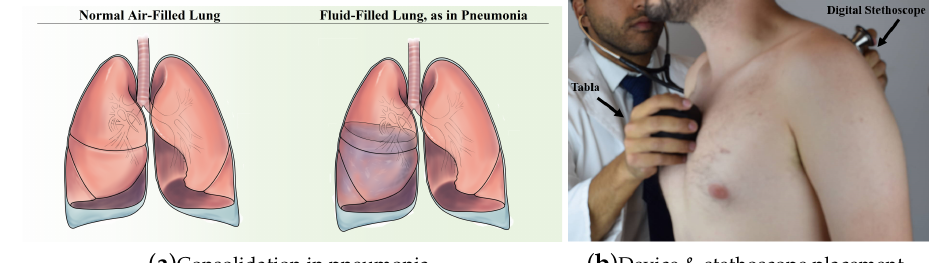
Figure 1. ( a ) a lung with consolidation characteristic of pneumonia and a healthy lung. Pneumonia leads to the accumulation of protein-rich fluid (exudate) in the lungs. The presence of exudate can be detected using different techniques, e.g., chest X-rays and acoustic analysis; ( b ) the Tabla is placed on the sternum and the stethoscope is moved to different quadrants of the lungs to record audio data, which is transmitted via Bluetooth to a smartphone (not shown). Figure from